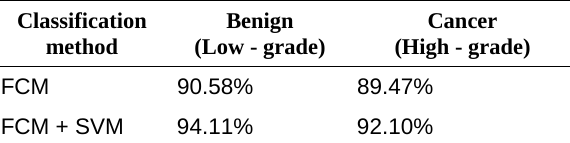
Table 4. Classification Accuracy